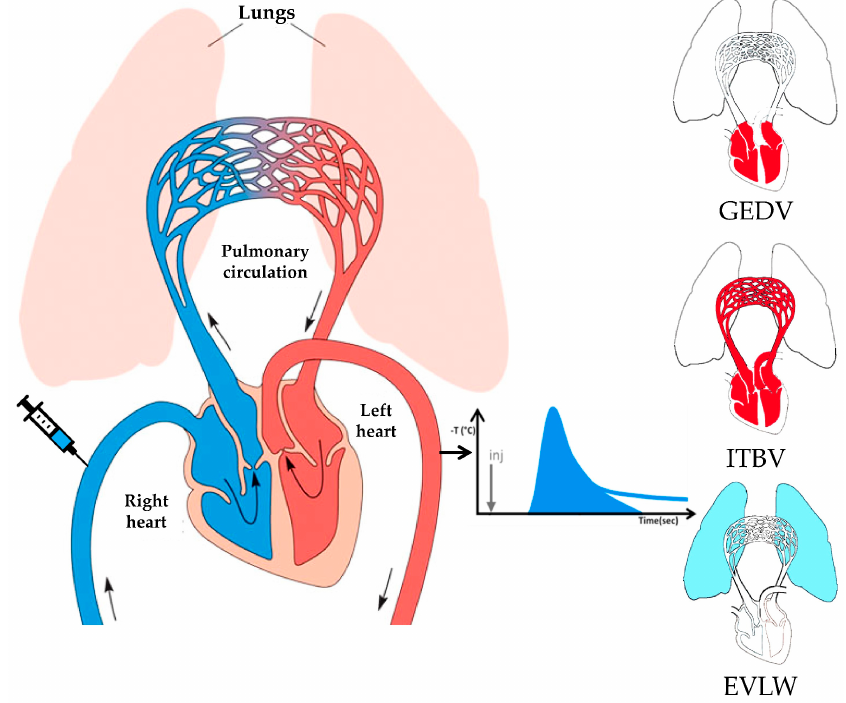
Figure 1. Schematic representation of intrathoracic volumes assessment by transpulmonary thermodilution (TPTD). The technique is based on central venous injection of cold saline and its detection close to the aorta usually via a femoral artery catheter. The temperature–time (thermodilution) curve generated after passage of the indicator through the central circulation and the lungs is illustrated on the right side of the site of detection. The three main volumes computed are depicted on the right side of the thermodilution curve. Global end-diastolic volume (GEDV) consists of left and right, atrial and ventricular end-diastolic volumes (top). Intrathoracic blood volume (ITBV) is the GEDV plus the pulmonary blood volume (middle). GEDV and ITBV are volumetric preload parameters. Extravascular lung water (EVLW), a pulmonary edema quantification index, is the volume of fluid in the pulmonary interstitium and alveolar spaces accessible to thermal di ff usion from the pulmonary capillaries (bottom). Figure modified from Non-Communicable Diseases, Emergency Care and Mental Health module of the HEAT Programme, Module: 1. Cardiovascular Diseases, 1.2 Anatomy and physiology of the heart. An OpenLearn Create chunk used / reworked by permission of The Open University © (2011), (https: // www.open.edu / openlearncreate / mod / oucontent / view.php?id = 287&printable = 1&extra =